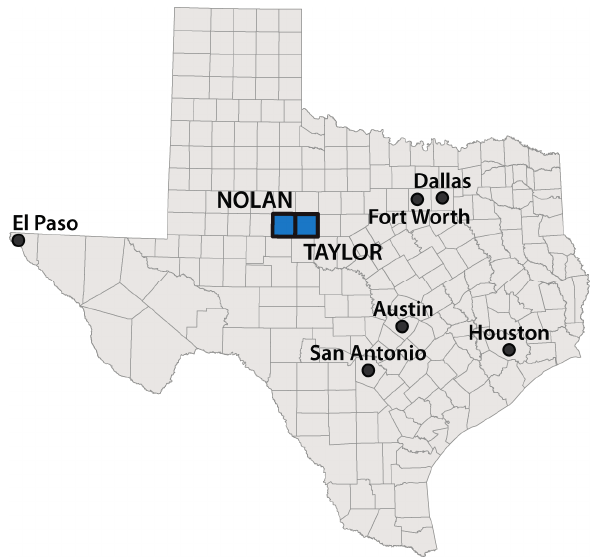
Figure 1. Nolan and Taylor Counties,